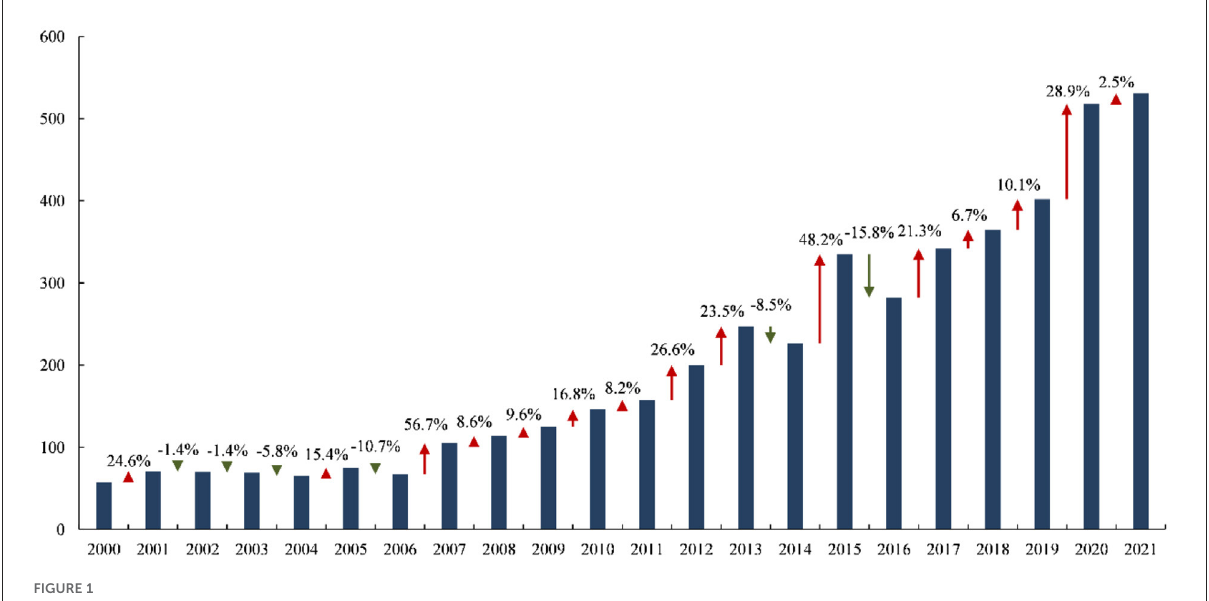
FIGURE1 Global trend in publications on ICU early mobilization.